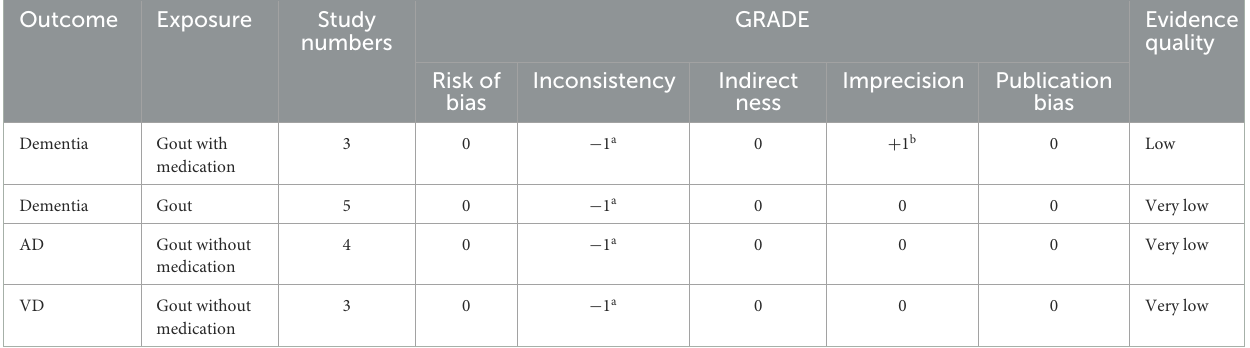
TABLE 3 GRADE certainty of